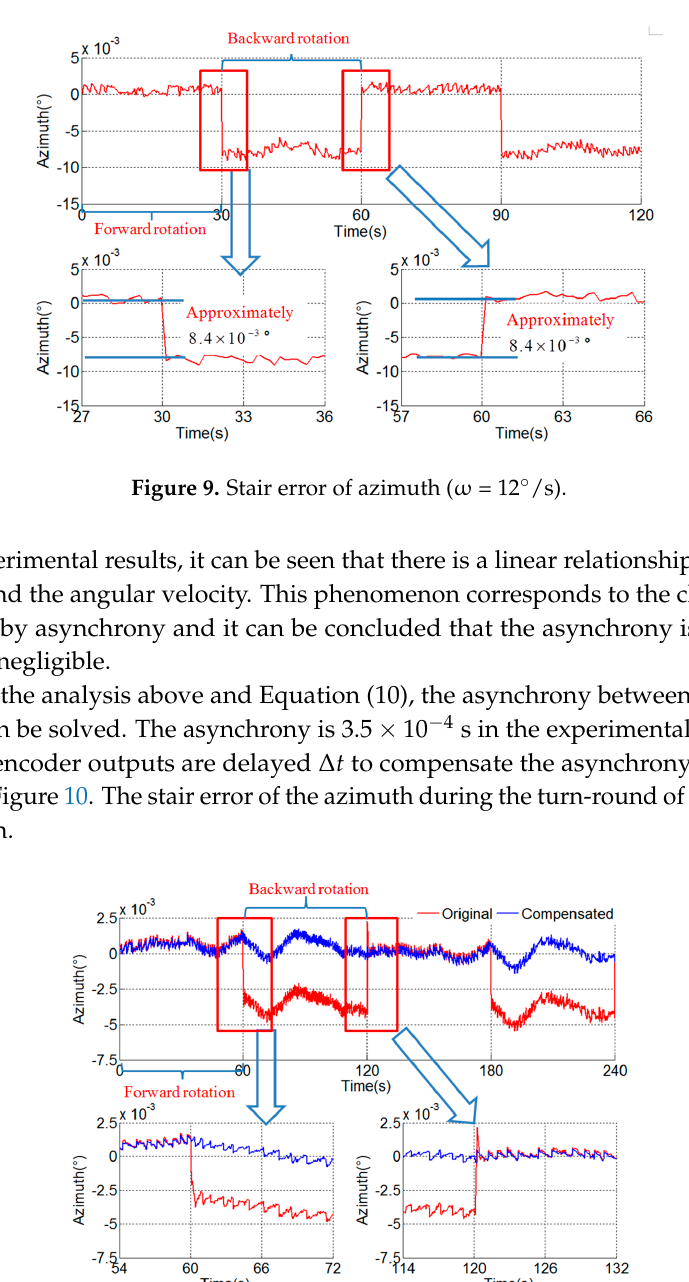
Figure 8. Stair error of azimuth ( ω = 1°/s).